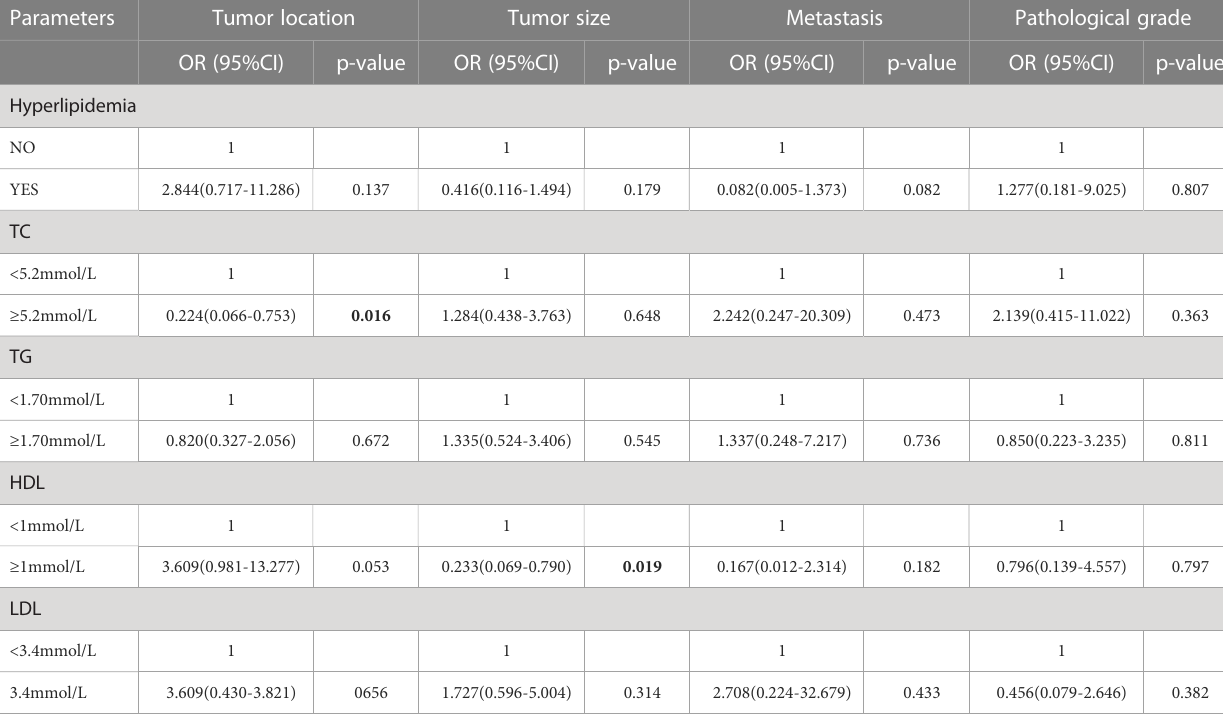
results of dyslipidemia (P > 0.05). 1 of 69 (1.4%) patients with insulinomas and 12 of 89 (13.5%) patients with NF-PanNENs died.